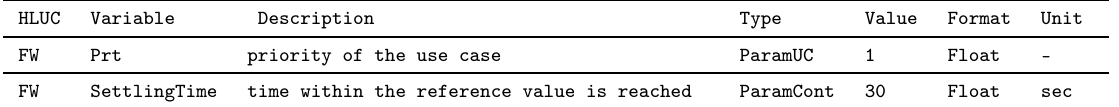
Table 12. Parameters of HLUC (FW).